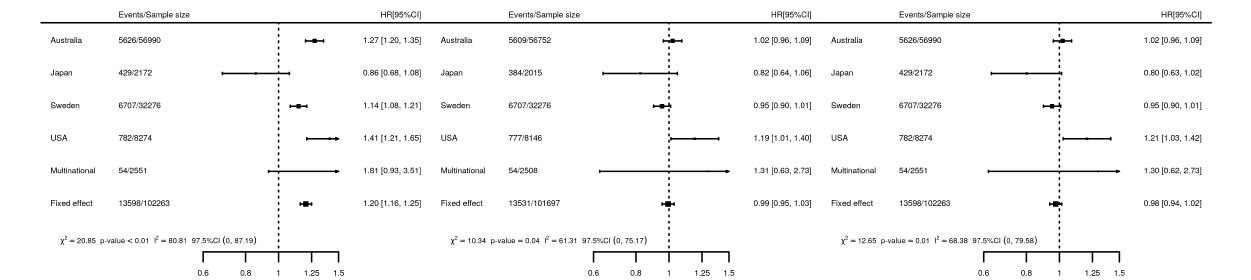
middle panel Figure 3 ), which diminished differences in survival